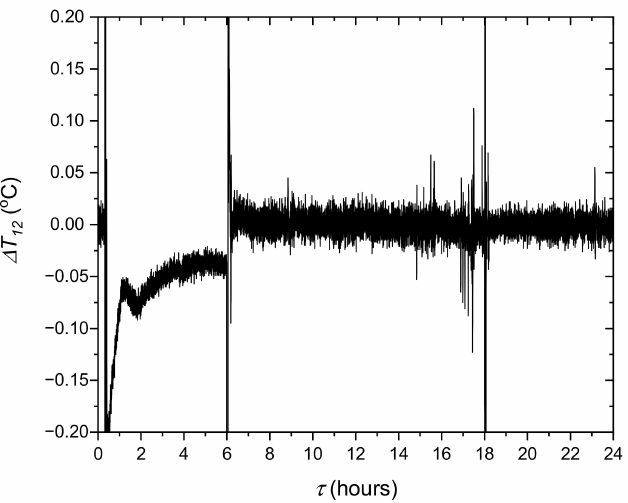
Figure 20. Evolution of the difference between the measured temperature T 4 and T m3 calculated in the model.